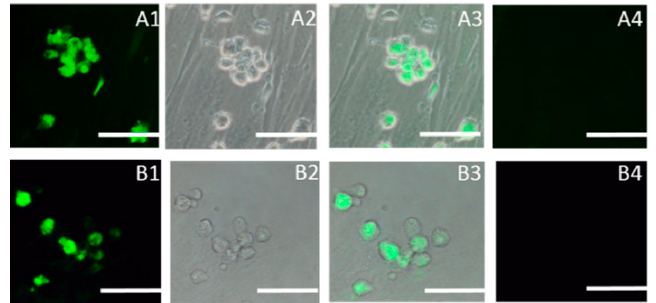
Figure 3. Immunocytochemical staining of SSCs using antibodies (FITC-conjugated secondary antibody, green) against SOX2 and SSEA-1 considered markers of pluripotency. ( A1 ) SOX2, dark field; ( A2 ) SOX2, bright field; ( A3 ) Merged with dark field and bright; ( A4 ) Negative control; ( B1 ) SSEA-1, dark field; ( B2 ) SSEA-1, bright field; ( B3 ) Merged with dark field and bright; ( B4 ) Negative control. Scale bar: 5 μ m.